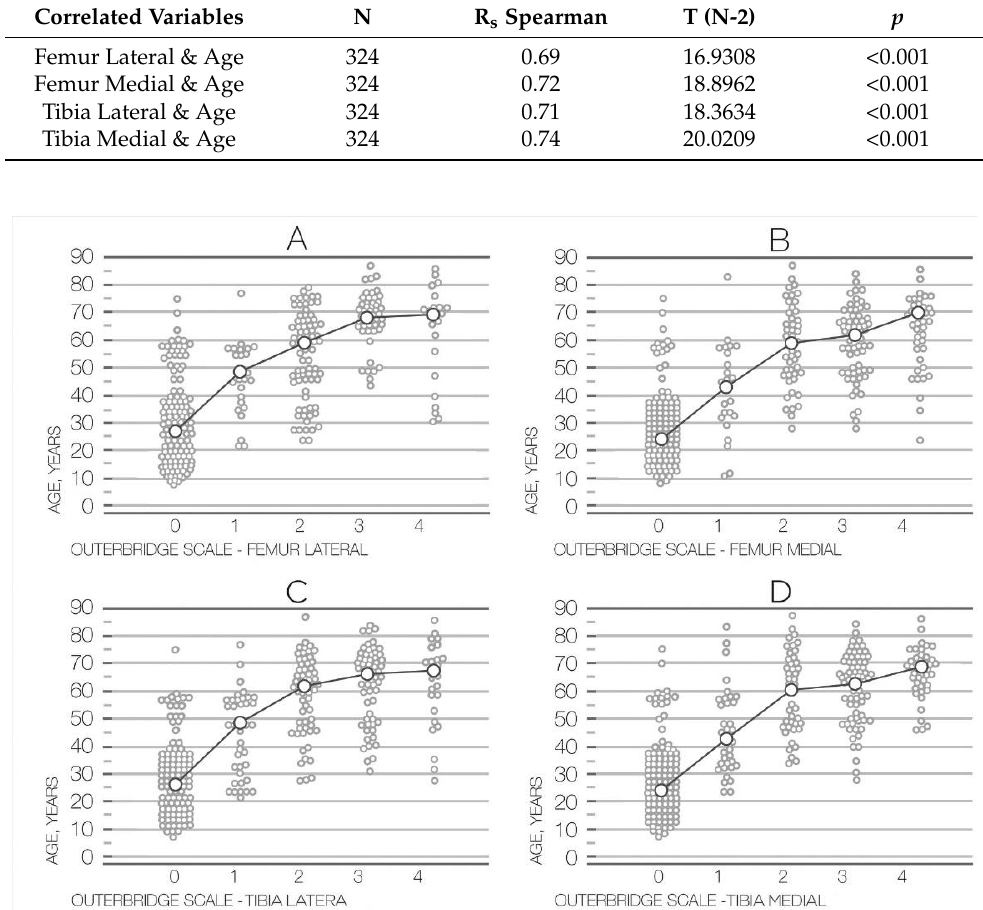
Figure 1. Relationship between the Outerbridge scale and age for femur lateral ( A ), femur medial ( B ), tibia lateral ( C ), and tibia medial ( D ).